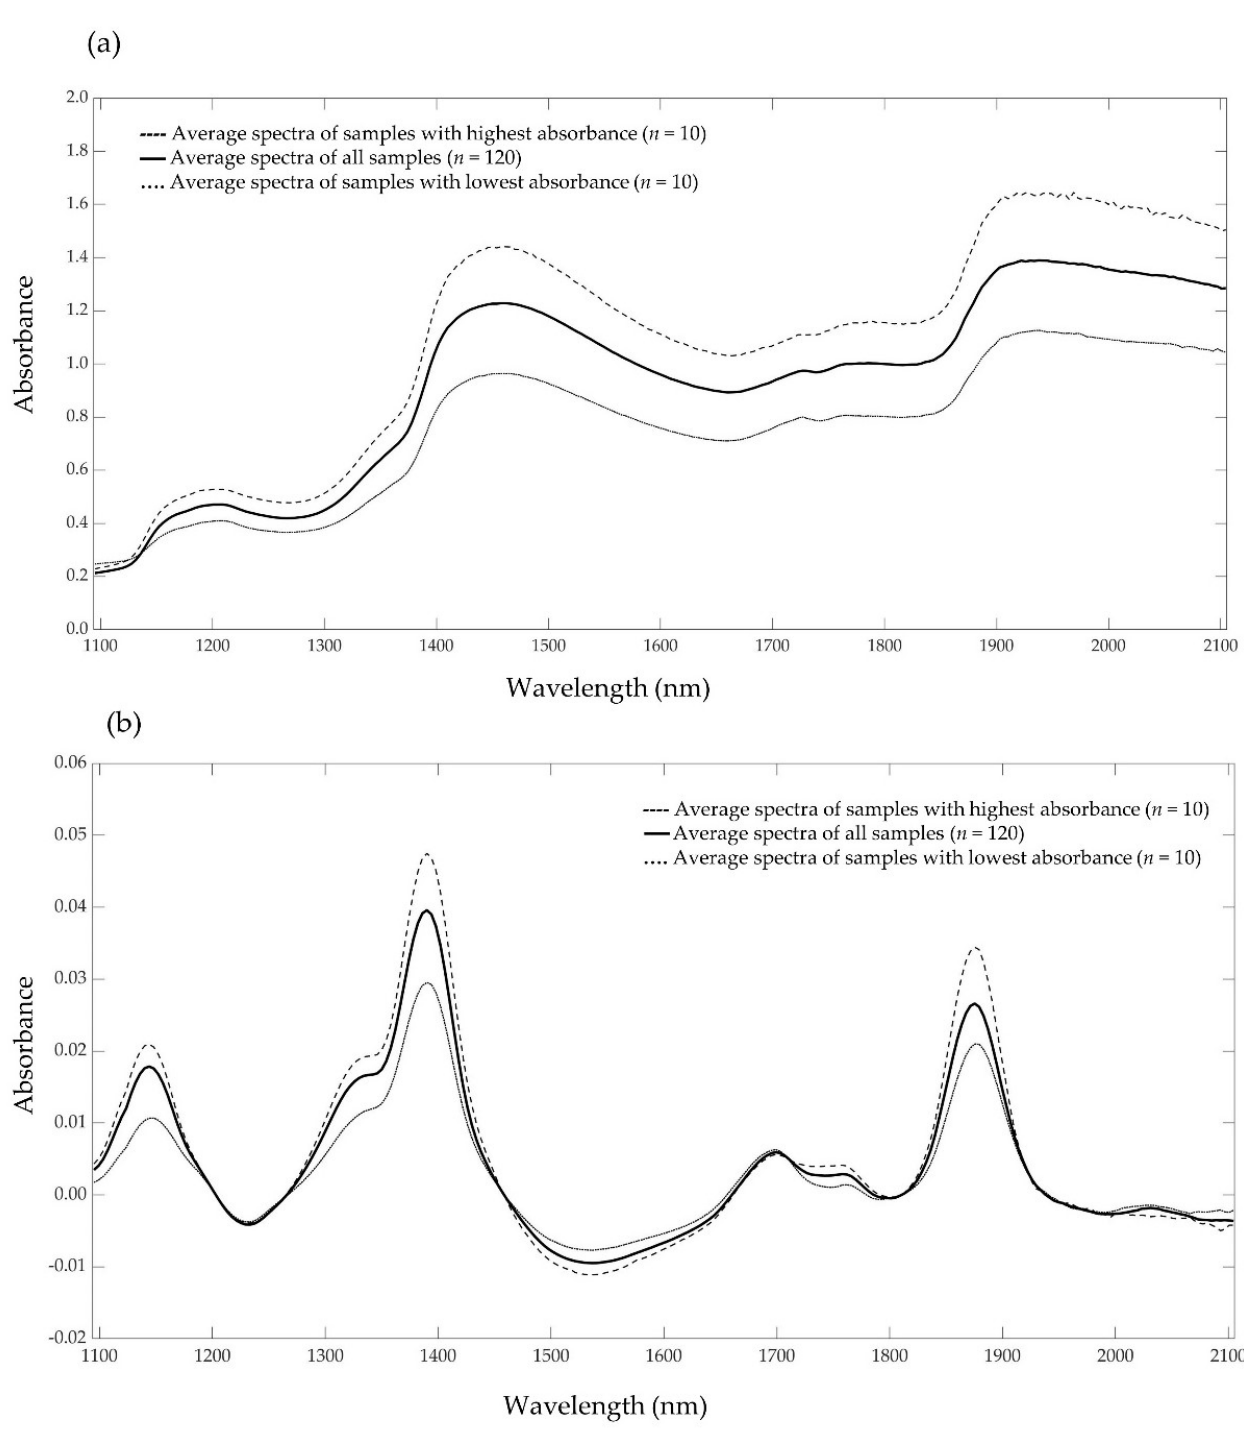
Figure 1. Average NIR raw spectra ( a ) and preprocessed spectra (1st derivative) ( b ) of living meal- worm larvae from samples with highest and lowest absorbance compared to all samples.